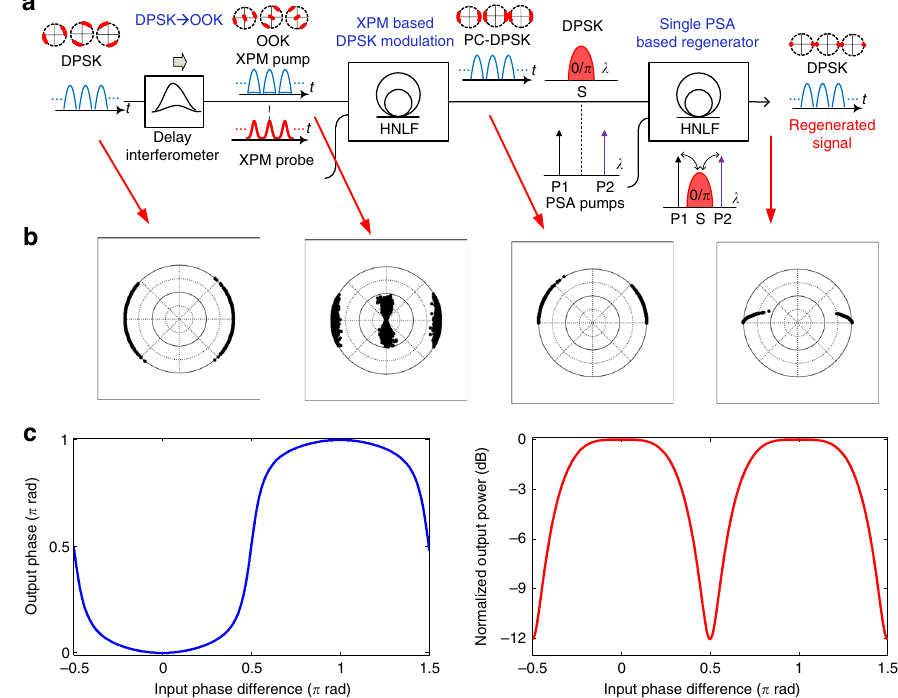
Fig. 3 All-optical phase regenerator based on a DI, XPM and PSA. a The incoherent serial DPSK signal is converted to an OOK signal using a 1-bit DI. An XPM stage is employed to transfer the data from the OOK signal to the phase of a coherent XPM probe. After combination with two phase-locked pumps, the obtained PC-DPSK signal is sent to a single PSA for phase regeneration. b Simulated constellation diagrams at the input of DI, outputs of DI, XPM and PSA. c Analytic output phase and power transfer function of the DI XPM and PSA-based optical phase regenerator with a gain of g =